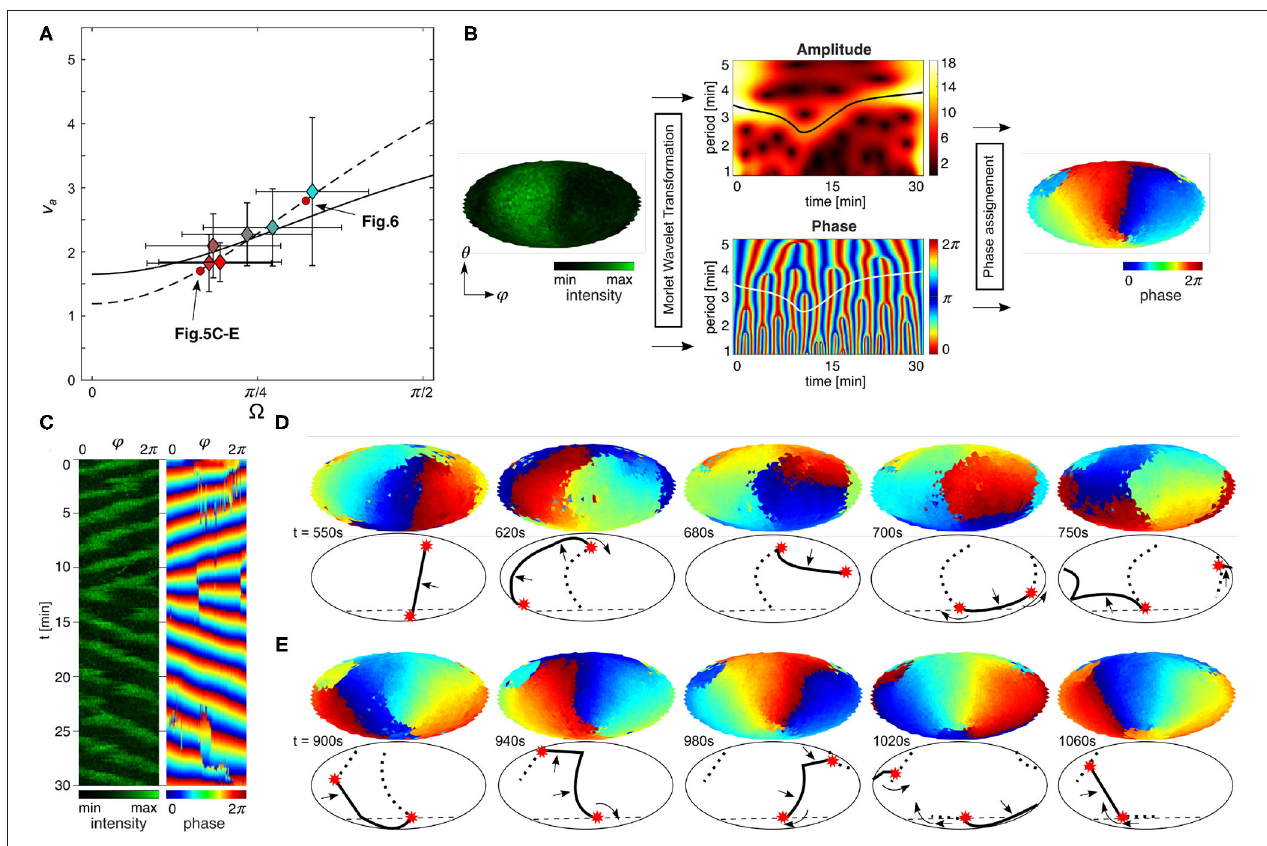
FIGURE 5 | Curvature of contact perimeter acts as pinning site of PIP3 spirals. (A) Relation between (cid:127) (contact angle) and v a (speed ratio). Dashed line is the weighted fit calculated from the linear fits in Figures 4F,I . Solid line is the non-weighted fit of all cells without considering 1α (see also Supplementary Figure 4 ). Color coding corresponds to α min (see Figure 4B ). (B) Scheme of the phase extraction on entire membrane. Phase of oscillating PIP3 at every spatial point was extracted from fluorescence intensity (left map) by Morlet wavelet transformation [WAVOS] following the approach of Taniguchi et al. (2013). Amplitude and phase of the wavelet transform (center maps). The frequency component having the maximum amplitude at each time point was obtained by ridge extraction (black solid line), and the phase was calculated accordingly (white solid line). Spatially distributed phase is extracted (right map). (C) Kymographs of fluorescence intensity and phase maps. (D,E) Oscillating waves in nearly spherical cells (see Figures 1B , 2E ). Phasemaps (top) and simplified schemes of the dynamics (bottom). (D) Change of domain front direction (solid line, 2 π ) from anticlockwise to clockwise wave direction by vertical phase line (dotted line) with one end pinned to the contact perimeter (dashed line). Phase singularities are denoted by red asterisks, and propagation direction with black arrows. (E) Spiral wave of PIP3 pinned to the contact perimeter (see lower red asterisk).